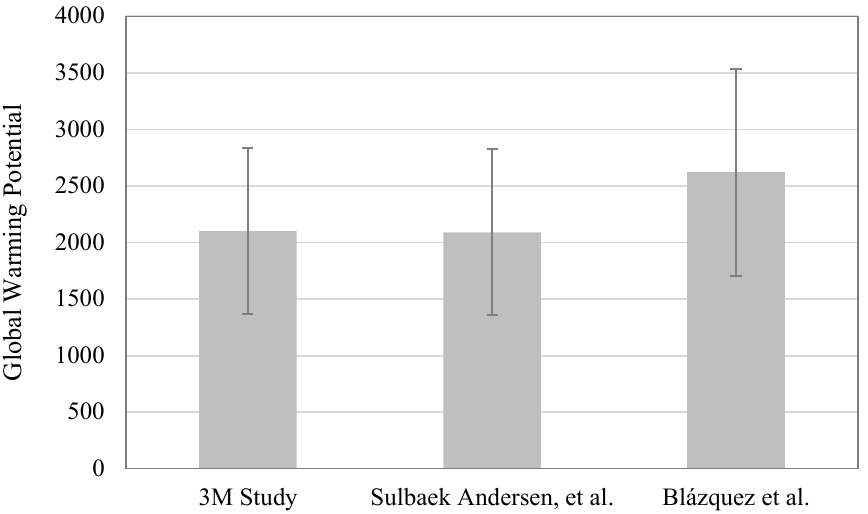
Figure 4. GWP values for Novec 4710 gas with uncertainty cited by IPCC.